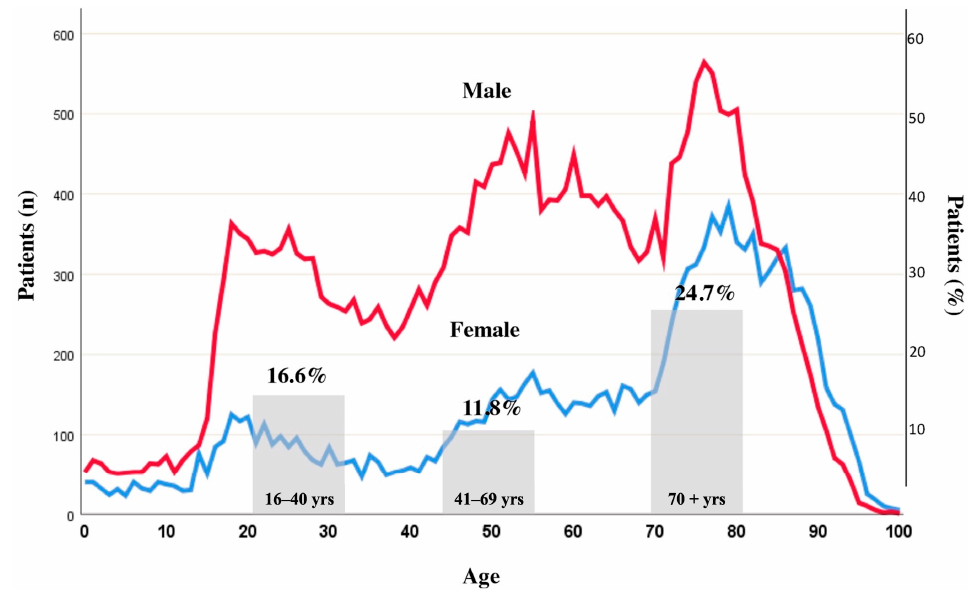
Figure 1. Trimodal age distribution of moderate to severe traumatic brain injury in men and women: 1. fi rst peak: marked di ff erence in incidence between the sexes, starting at puberty and rising until age 18 (driver(cid:31)s license); “testosterone e ff ect” > “young risk-takers”; male > female); 2. second peak: